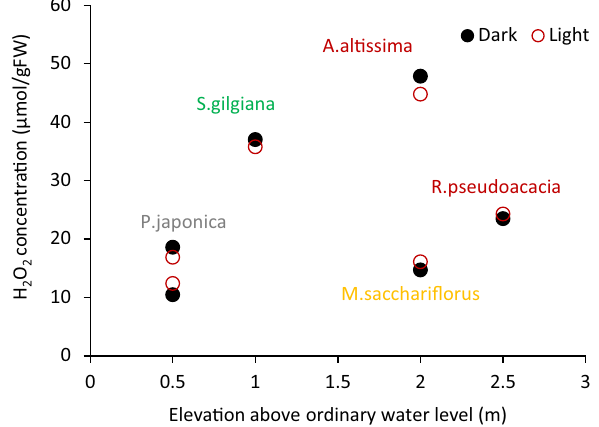
Figure 8. H 2 O 2 concentration differences of light-exposed and dark-adapted samples.